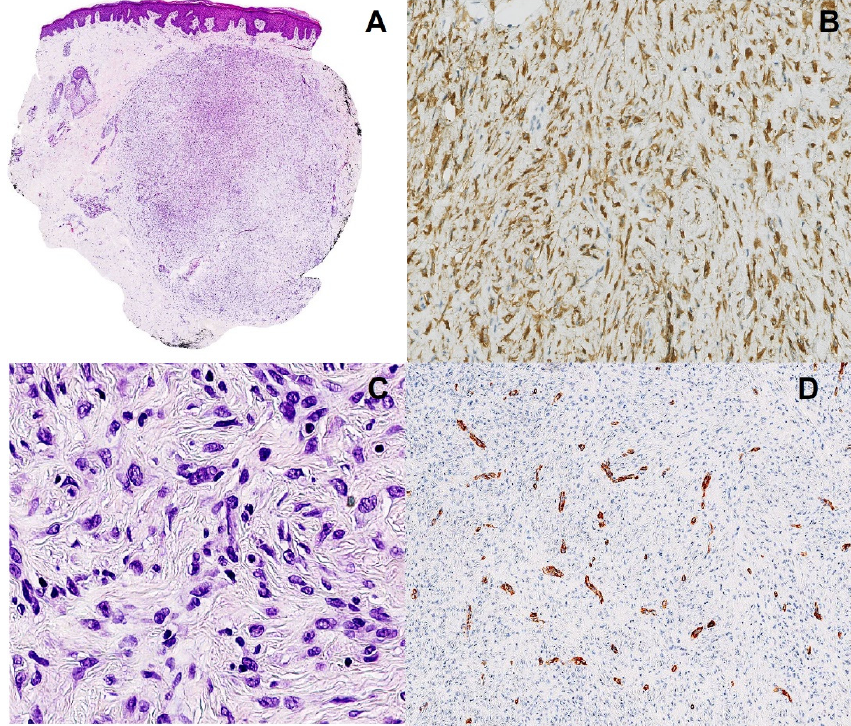
Figure 1. Pathological findings. ( A ). Silhouette of the lesion showing epidermal hyperplasia, dermal nodule with endophytic growth (magnification × 12.5). ( B ). Cytoplasmic staining with ALK1 antibody (immunohistochemistry), highlighting the dendritic shape of the cells (magnification × 200). ( C ). Dendritic to epithelioid cells, with ovoid vesicular nuclei and tiny nucleoli, arranged in a whorled fashion (hematoxylin and eosin, magnification × 200). ( D ). Smooth muscle actin immunohistochemistry, showing small vessels within the tumor, without staining of the tumor cells (magnification × 200).